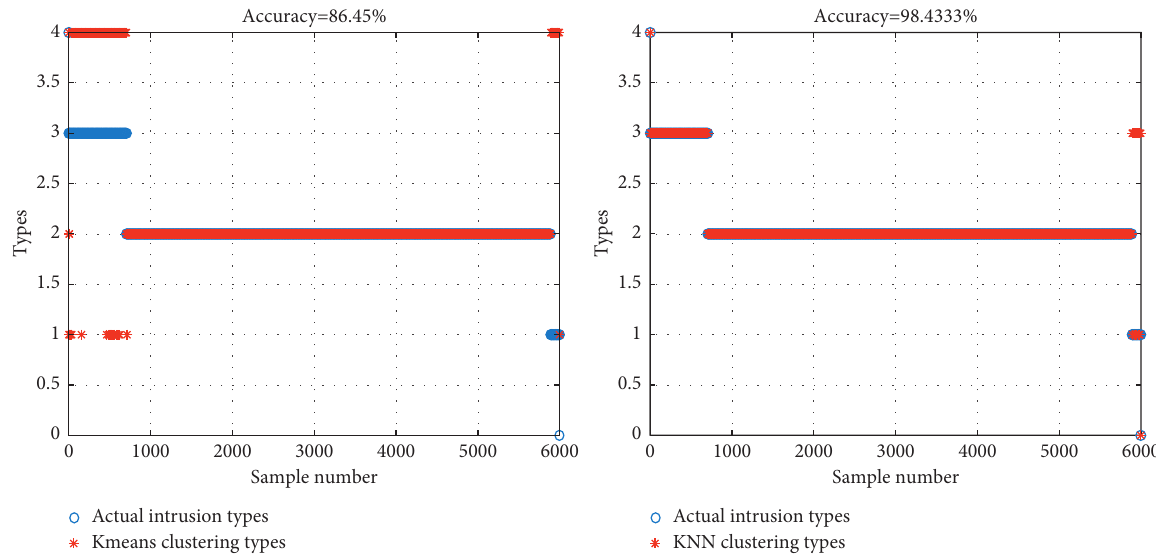
Figure 4: Comparison of two kinds of clustering classification